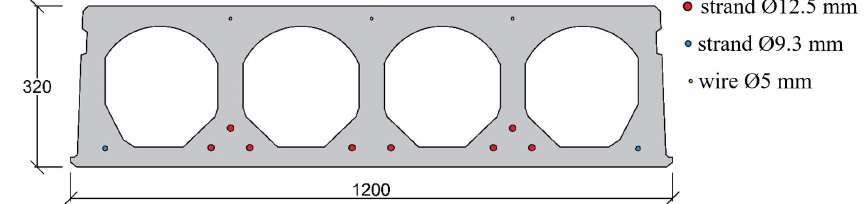
Figure 3. Hollow core slab section (dimensions in mm).